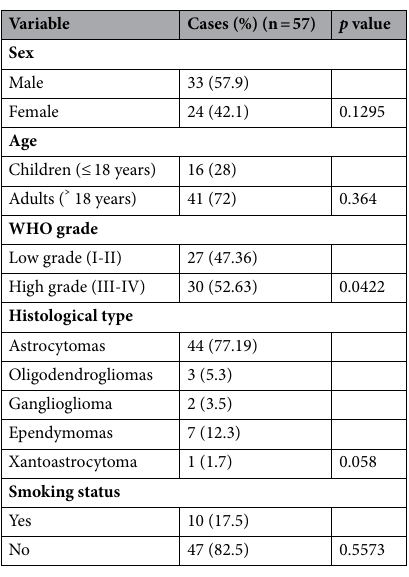
Table 1. Expression of VISTA depending on patient